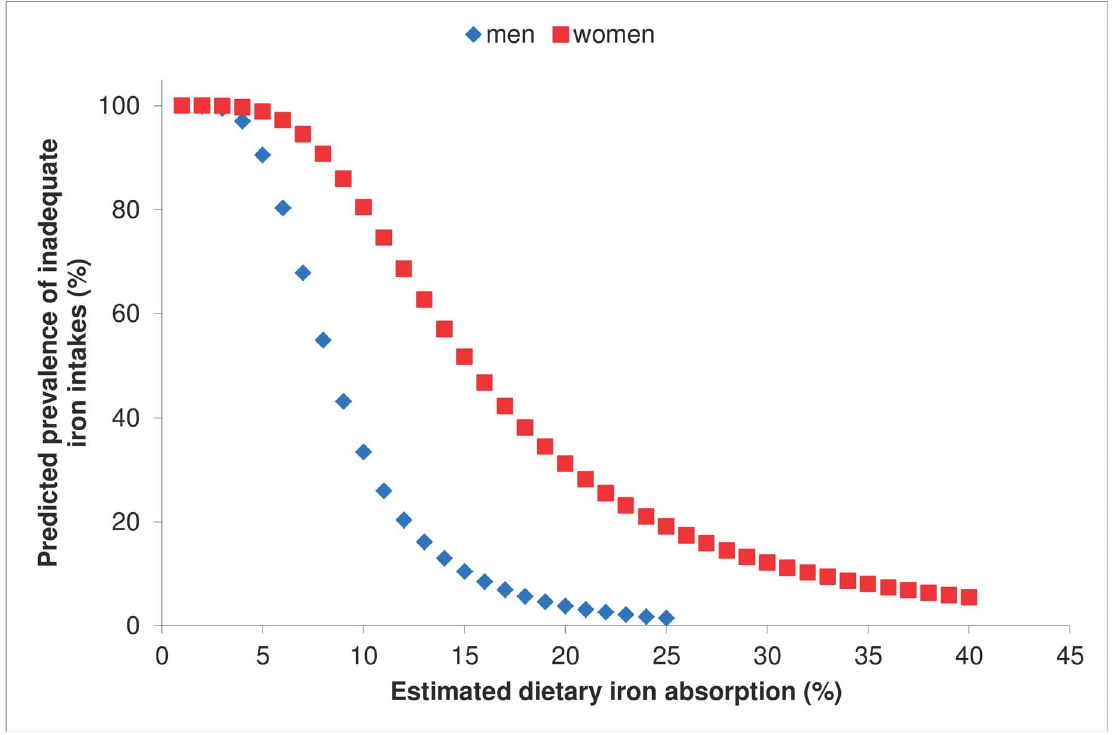
Figure 3. Results of probability modelling with NDNS data for men ( ¤ ) and women ( & ): y axis represents the predicted prevalence of inadequate intakes (0–100%), x axis is estimated dietary iron absorption (%).